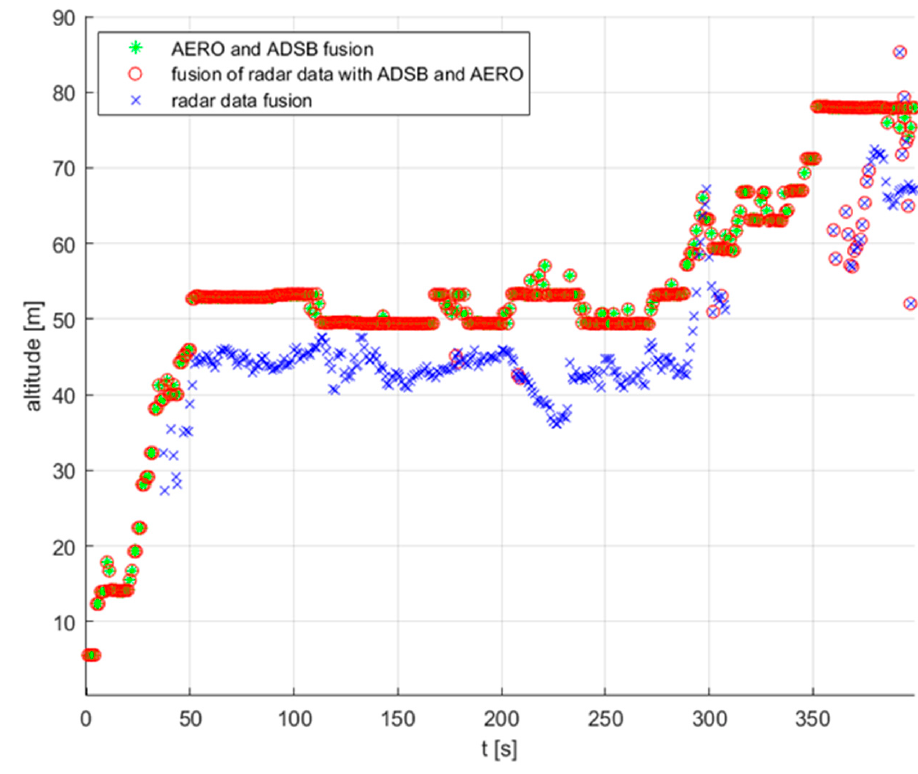
Figure 11. UAV flight altitude plot.